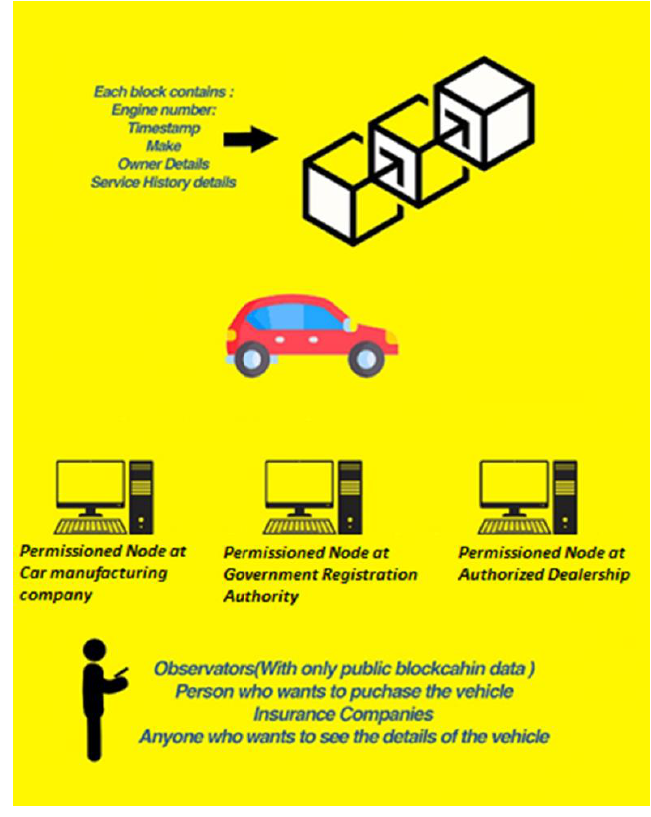
Figure 5. Permissioned nodes in the network.